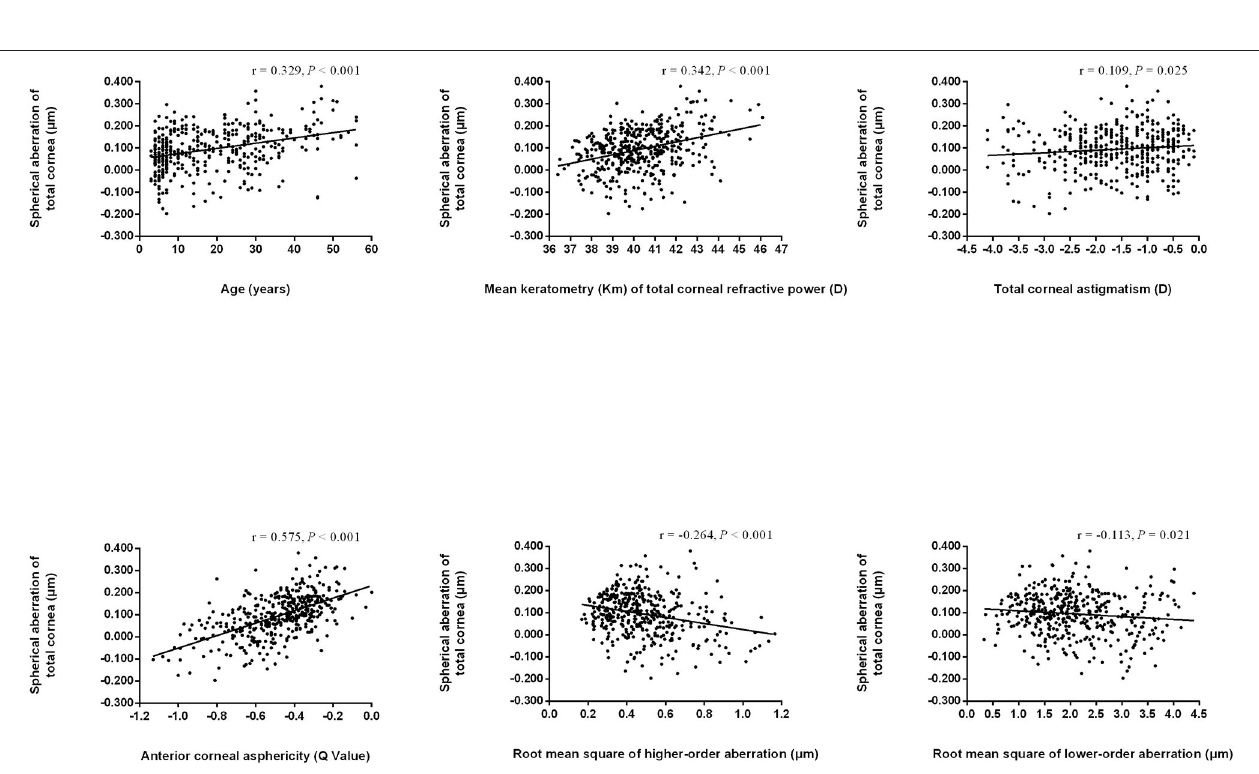
FIGURE 3 | Scatter plots indicating correlations of total spherical aberration of the cornea with other biometric parameters. Regression lines are drawn when the regression analyses are statistically significant.